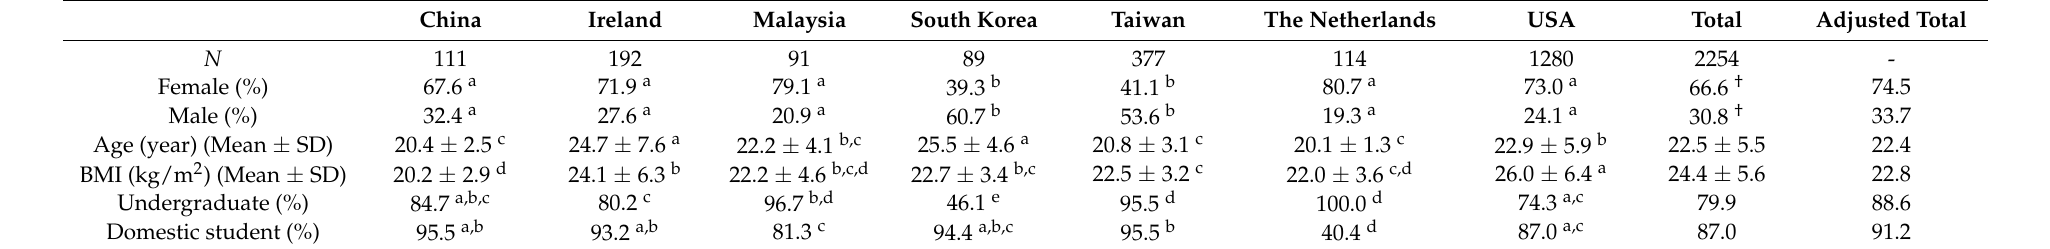
Table 1. Demographic and anthropometric information of higher education students from 7 countries.